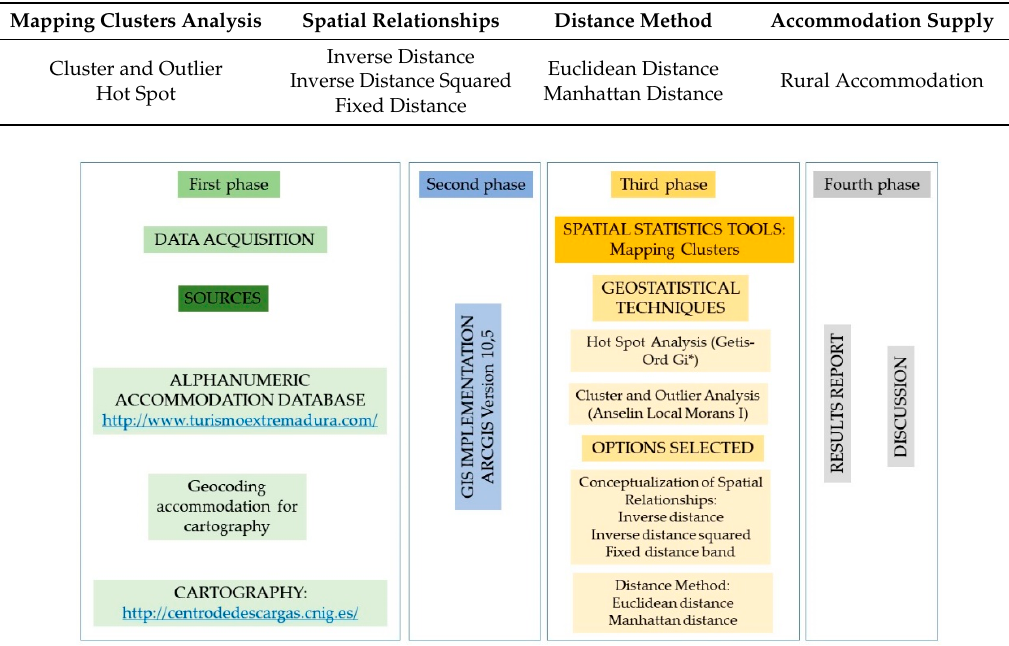
Table 2. Option matrix.